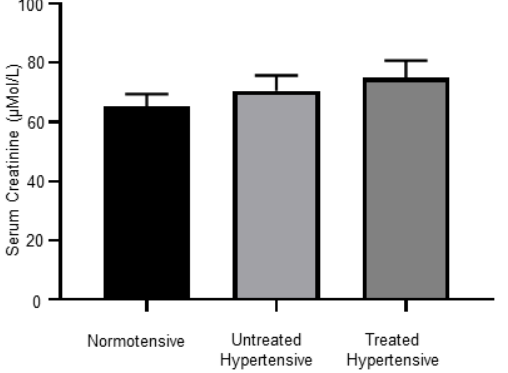
Figure 5. Serum creatinine levels; n = 12–16 subjects/group. All data are presented as the mean ± SEM.